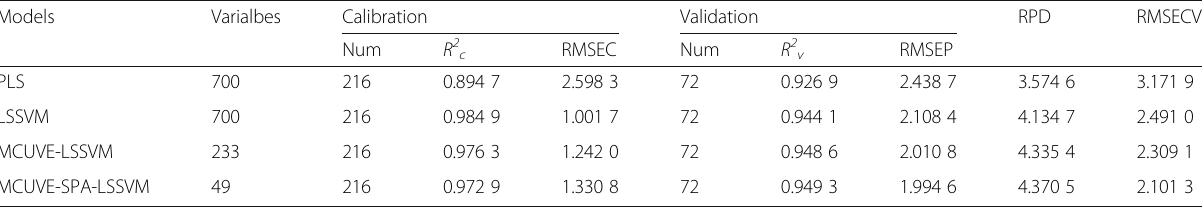
Table 3 The performance of four kinds of regression models